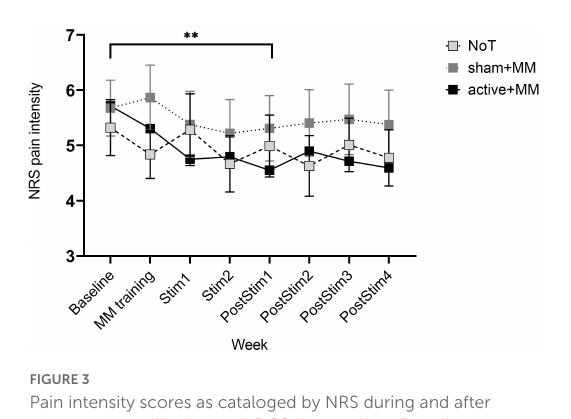
FIGURE5 Relationship between quality of life and pain intensity: acute effects. A correlation analysis between FIQ scores at T acute corrected to T baseline and NRS pain intensity at PostStim1 corrected to baseline. N = 30, all patients were included for this analysis. The fitted line is the plotted linear regression as mean with standard error of the mean.